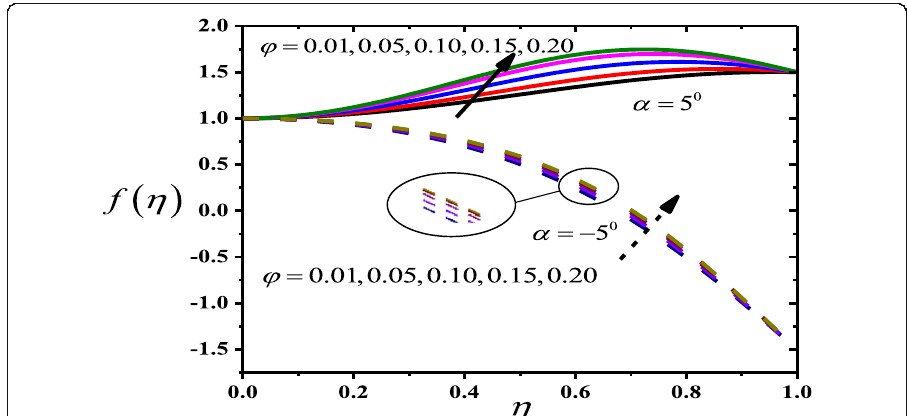
Fig. 14 Velocity vs. φ in stretching divergent and shrinking convergent channels